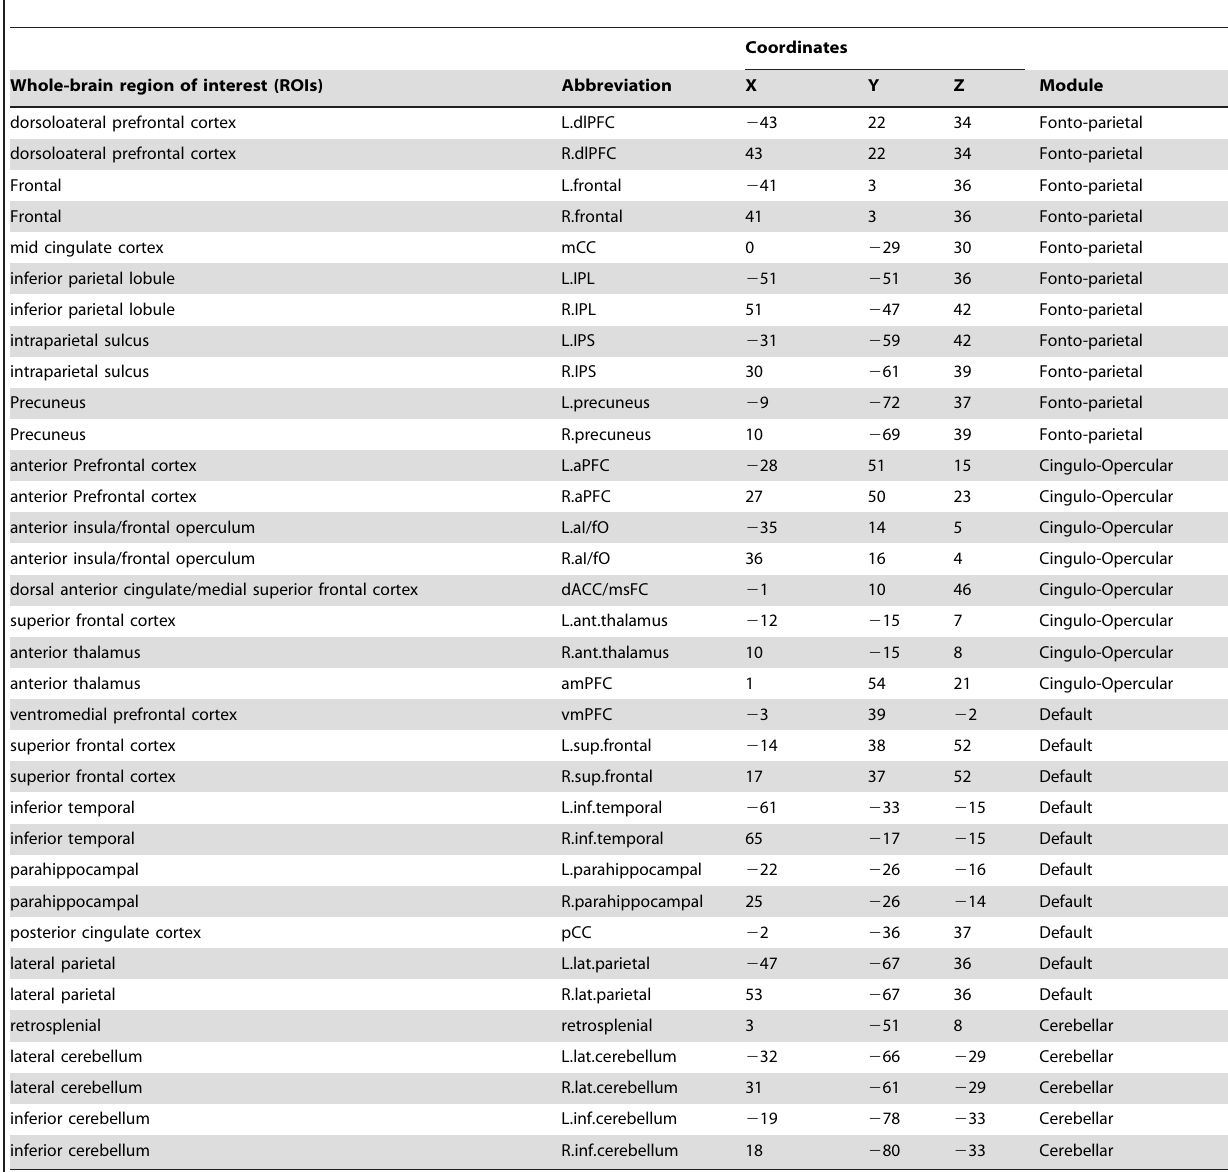
Table 1. Regions of interest used as nodes in the network network analysis, drawn from